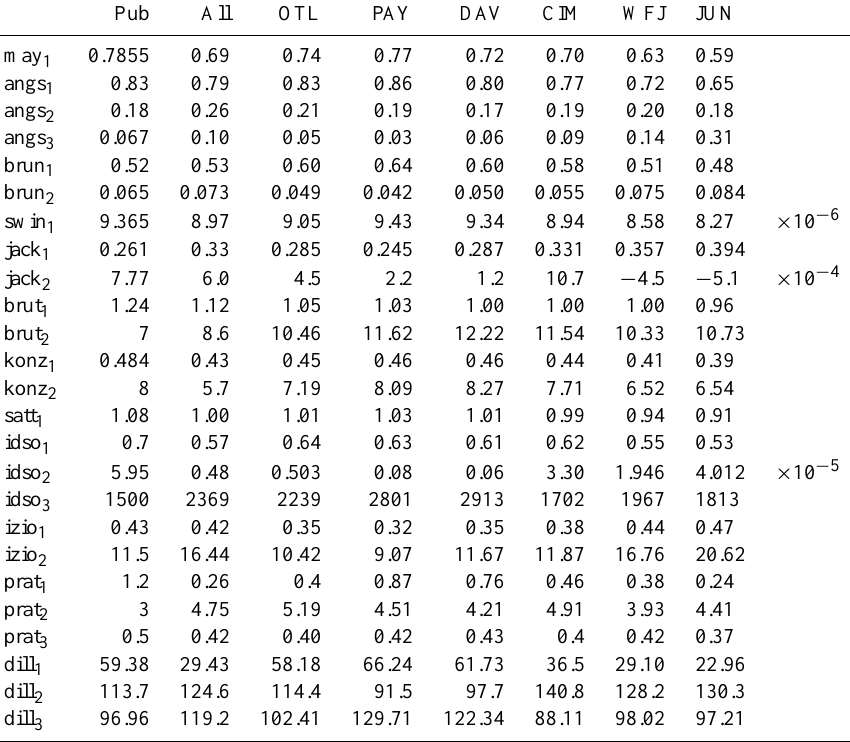
Table 4. Values of the fitted parameters of the clear-sky LDR parameterizations to the six locations. The first column indicates the published parameter values and the second column indicates the estimated parameters when the stations are treated simultaneously.